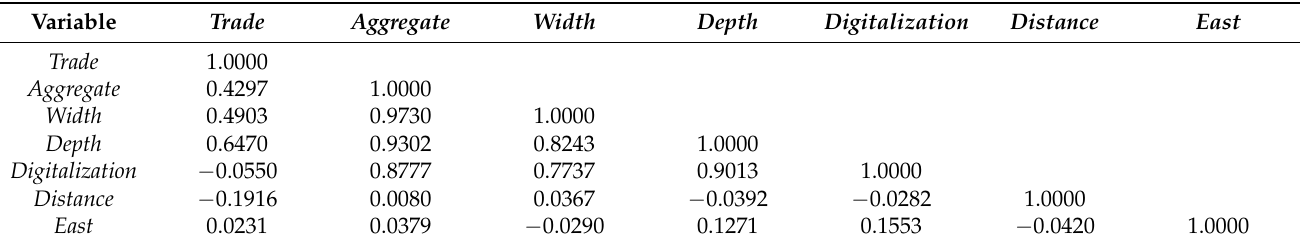
Table 2. The correlation coefficients between